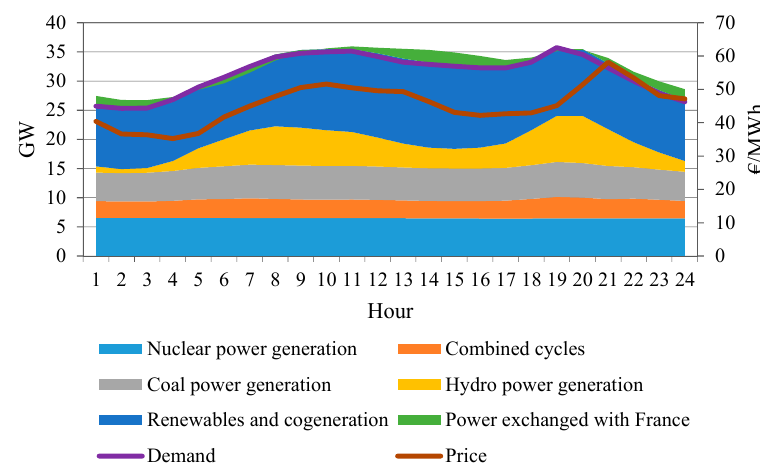
Figure 3. Hourly mean electricity generation, demand and real price of electricity in April 2015.